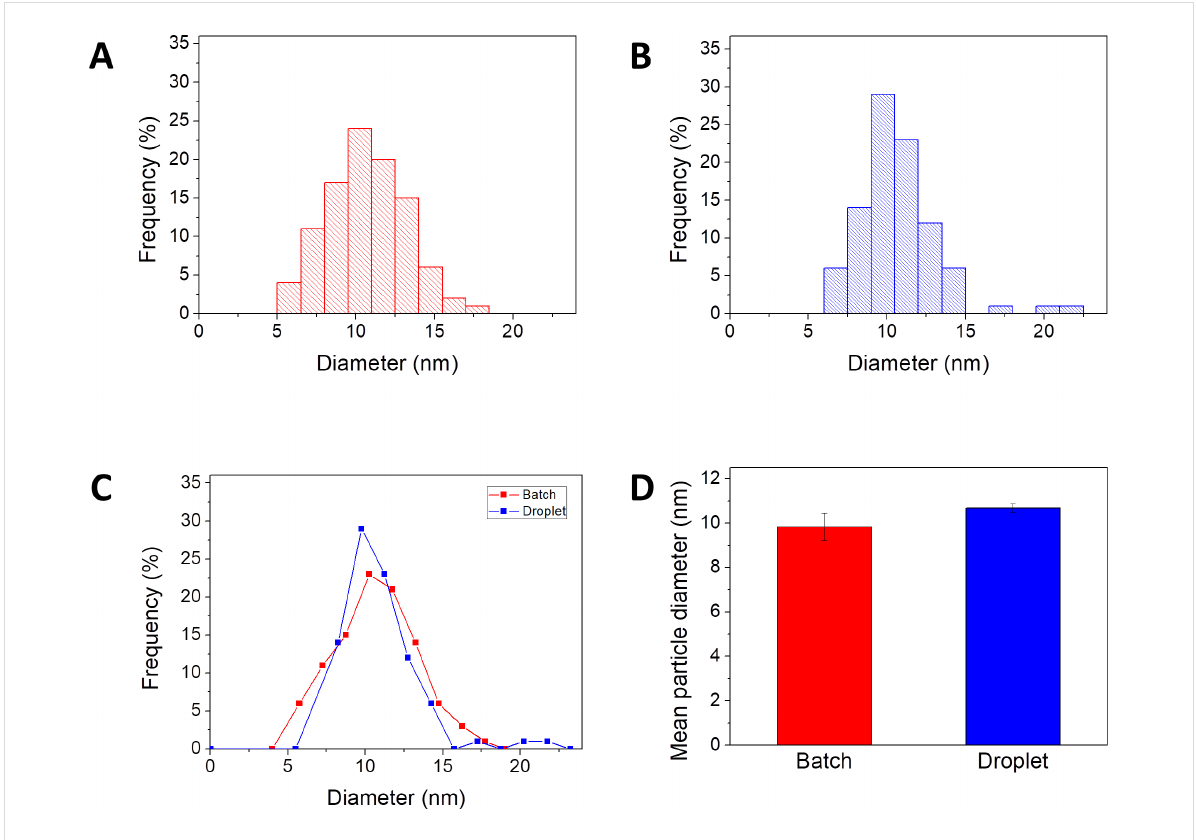
Figure 4: Histograms of magnetic nanoparticle size of particles synthesized in batch (A), and in droplets (B) under the same conditions. Overlay of the two particle distributions (C). Bar diagram showing the reproducibility of the reaction, three independent synthesis were conducted for each method and the mean particle diameter of the three synthesis is indicated by the bars